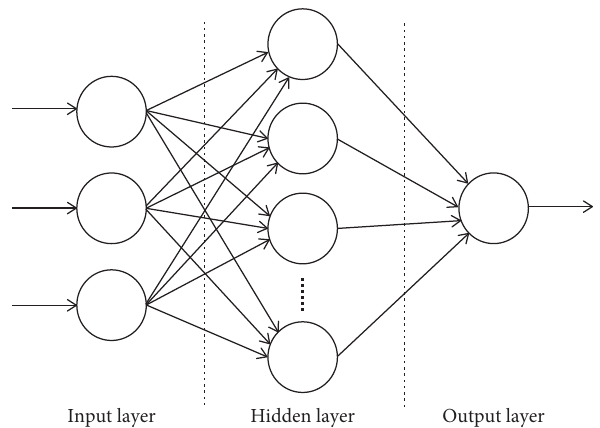
Figure 1: Schematic diagram of a multilayer feed-forward neural network [37,